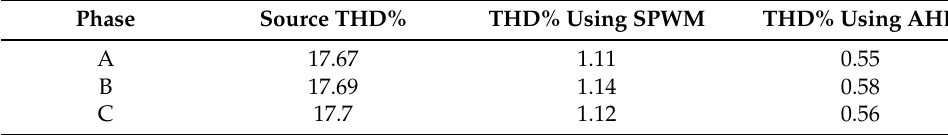
Figure 13. The simulation results of voltage harmonics ( a ) Source voltage, ( b ) injected voltage, and ( c ) load voltage. Table 8. The THD for the case of voltage harmonic